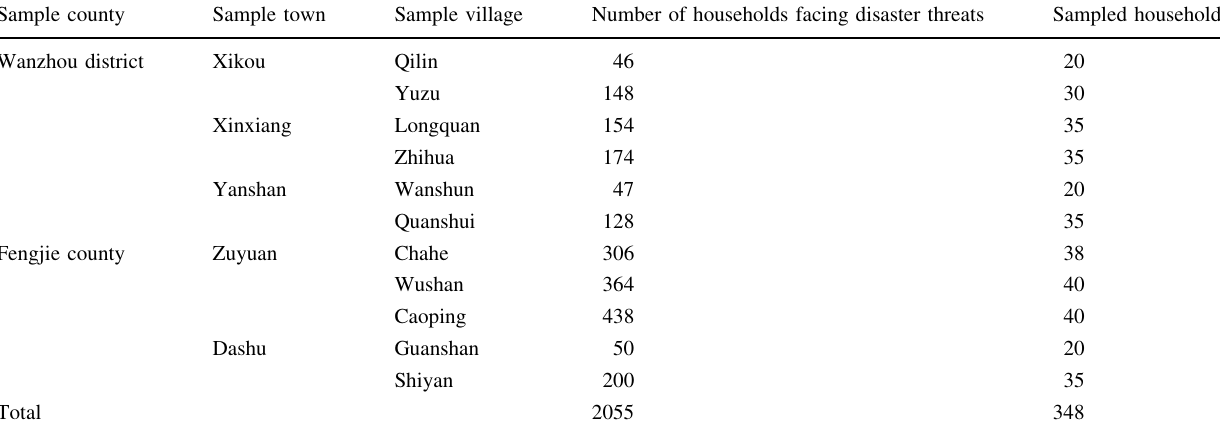
Table 1 Summary statistics for households facing disaster threats in the sample villages in the Three Gorges Reservoir study area Sample